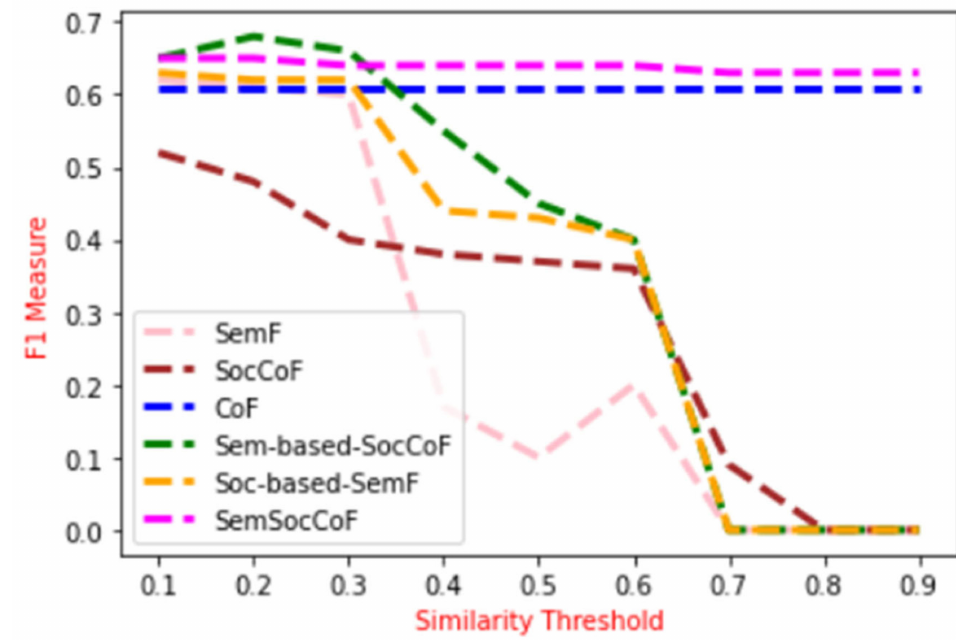
Figure 14. Comparison of F1 measure of various algorithms.